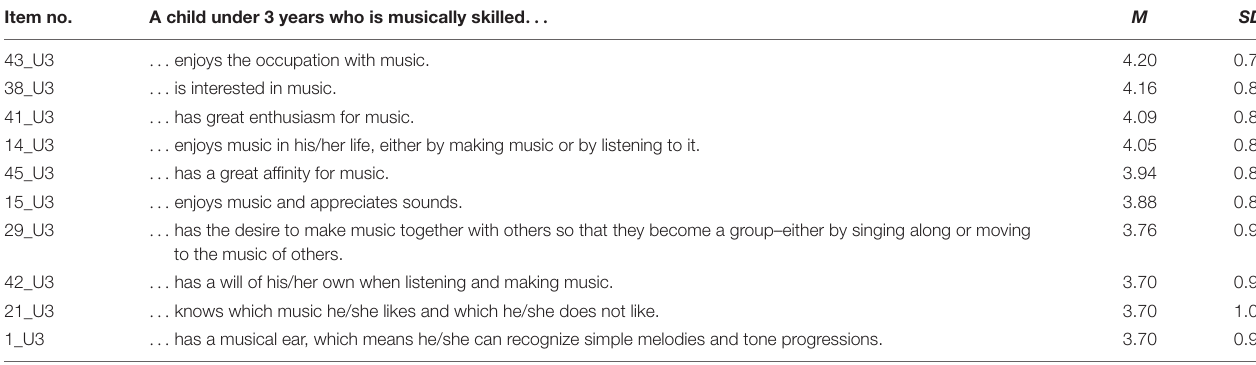
TABLE 1 | Highest rated items of the Musical Infant/Toddler Questionnaire (MCQ_U3). Item no.